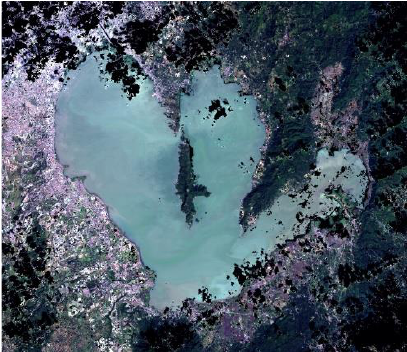
Figure 5. Cloud and cloud shadow masked Landsat 8